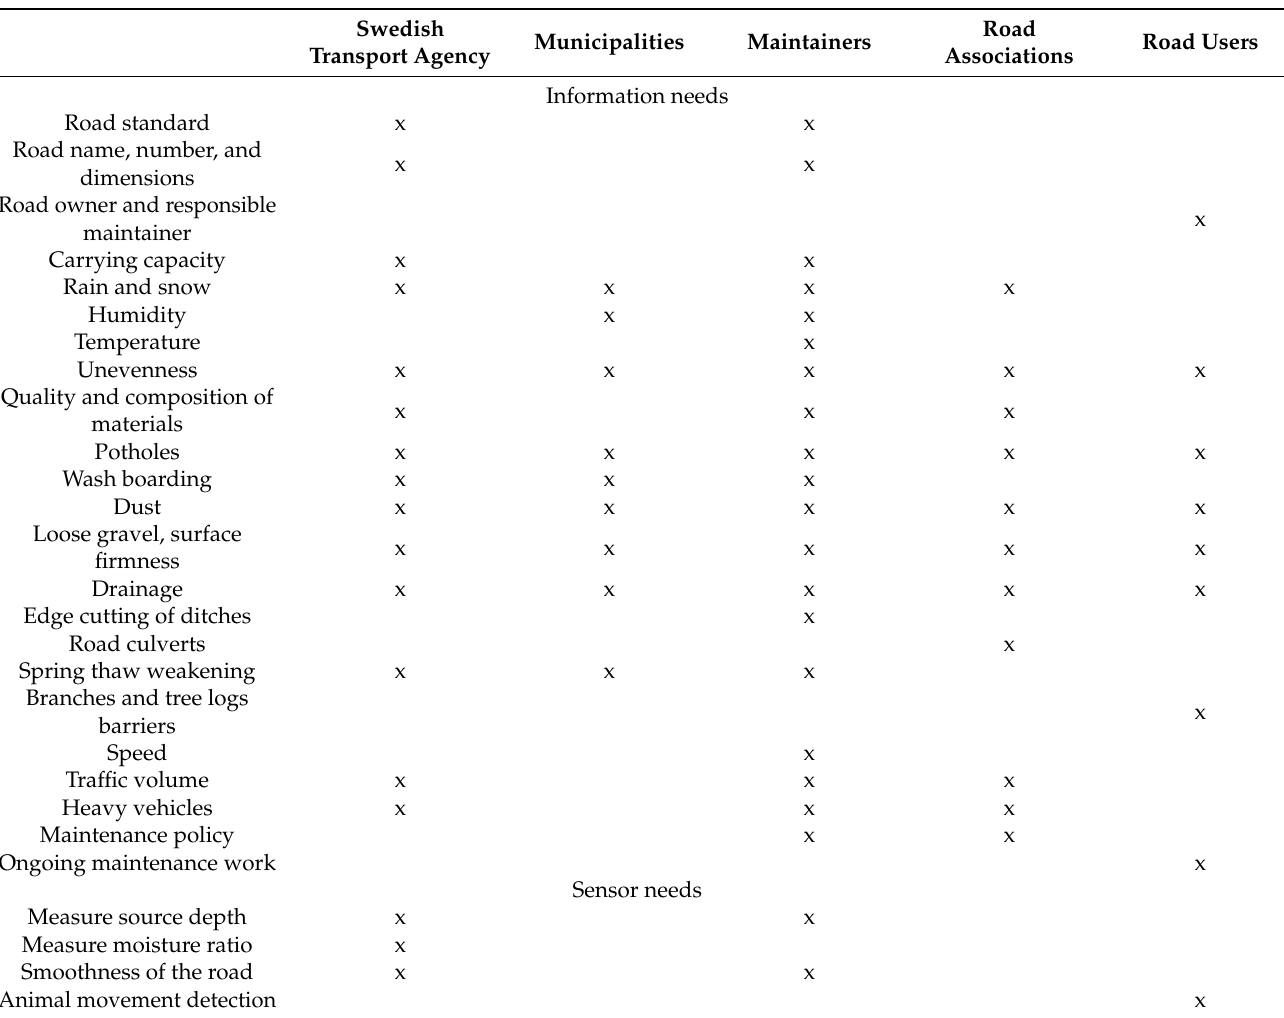
Table 2. Similarities in interview